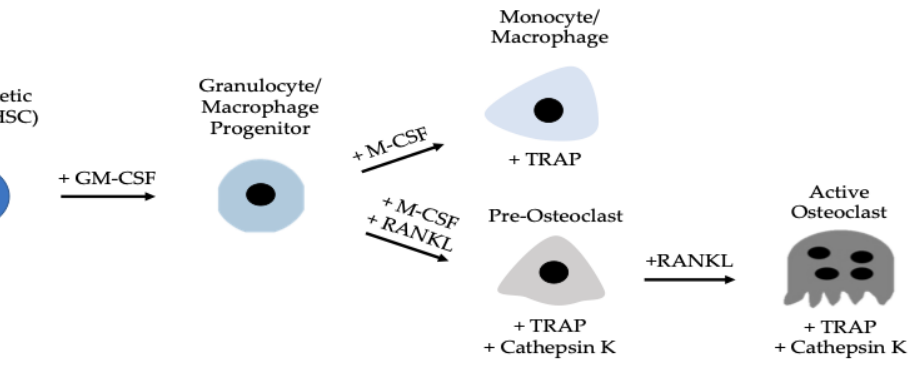
Figure 1. Development of an active osteoclast. Hematopoietic stem cells (HSCs) differentiate into GMPs, which express c-fms receptors that M-CSF ligands can bind. After binding, GMPs differentiate into monocyte/macrophage precursors, that further differentiate into pre-osteoclasts and active osteoclasts when RANKL binds to RANK receptors. Active osteoclasts are multinucleated and express TRAP and Cathepsin K.